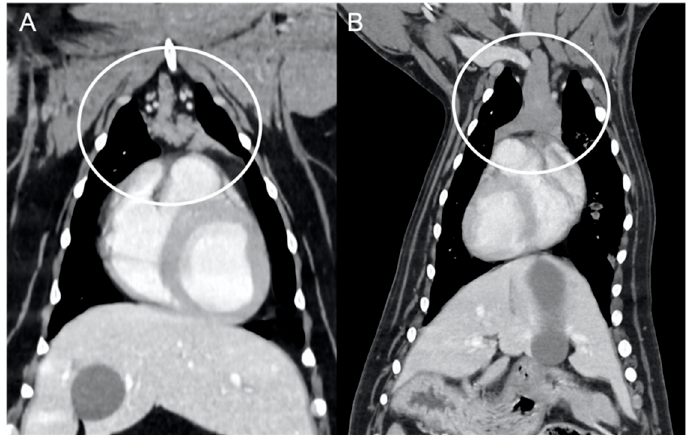
Figure 3. Appearance of the parenchyma of the thymus (circled) in an adult dog ( A ) compared to a young dog ( B ). Post-contrast transverse CT images. The appearance is lobulated in adult dogs ( A ) and homogeneous in young dogs ( B ).